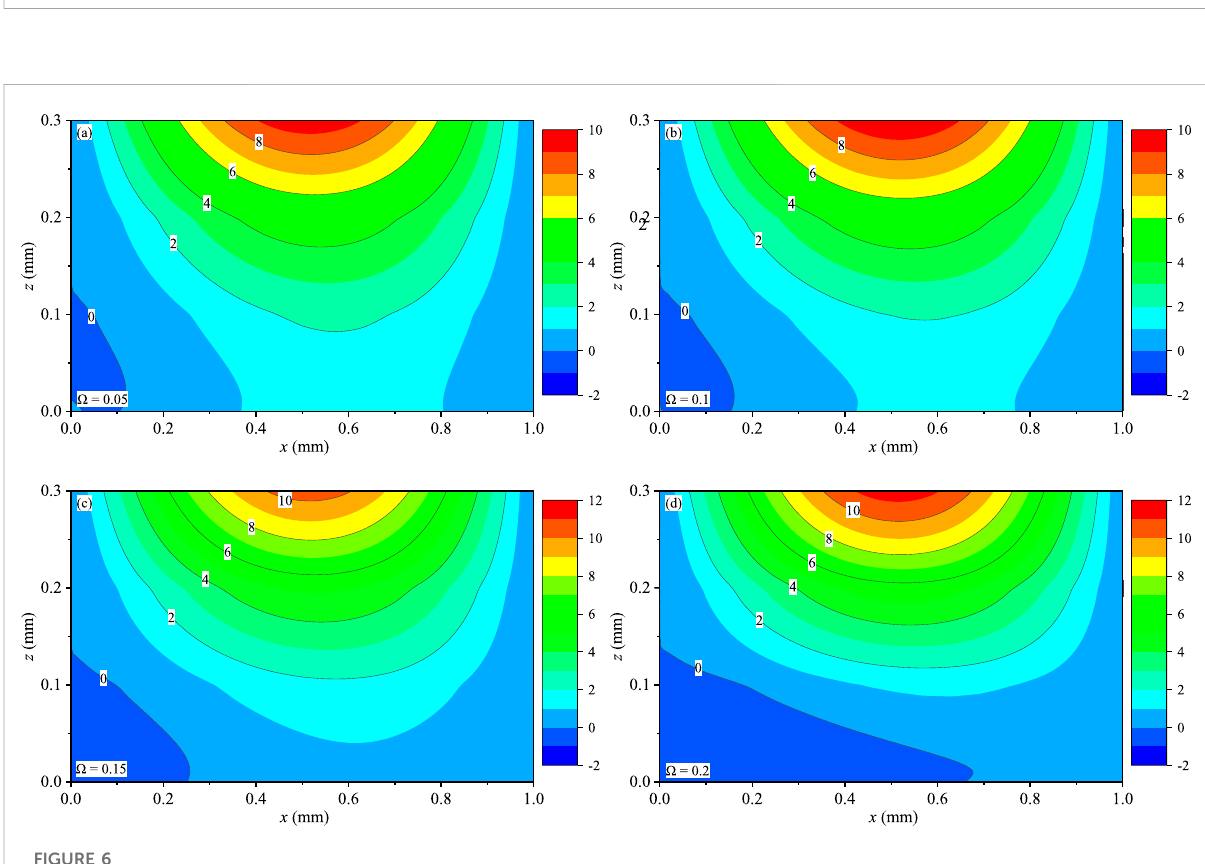
FIGURE 6 Effect of Ω on the phonon displacement u z (10 − 7 mm): (A) Ω = 0.05, (B) Ω = 0.1, (C) Ω = 0.15, and (D) Ω =